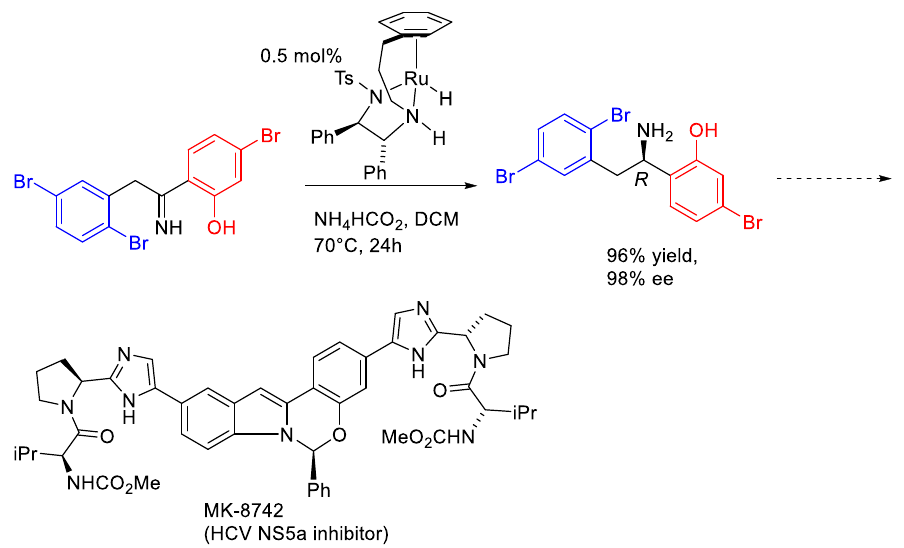
Figure 13. A reported imine ATH using a tethered catalyst.